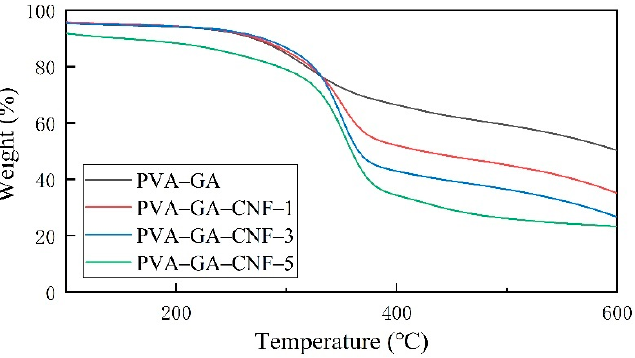
Figure 7. Thermogravimetric analysis of PVA–GA aerogels and PVA–GA–CNF ‐ (1, 3, 5) aerogels .